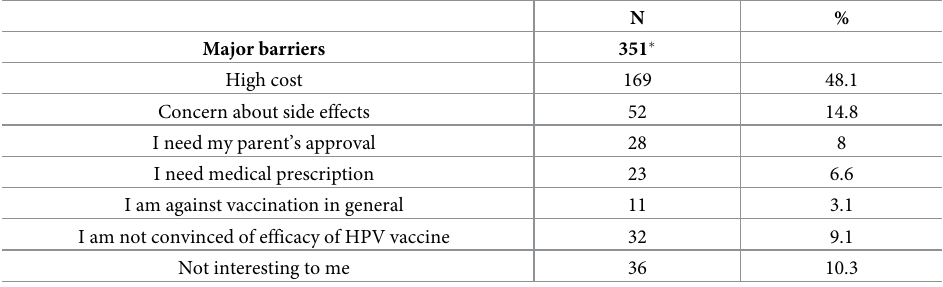
Table 3. The major barriers to willingness to get the HPV vaccine. Morocco between May 2019 and June